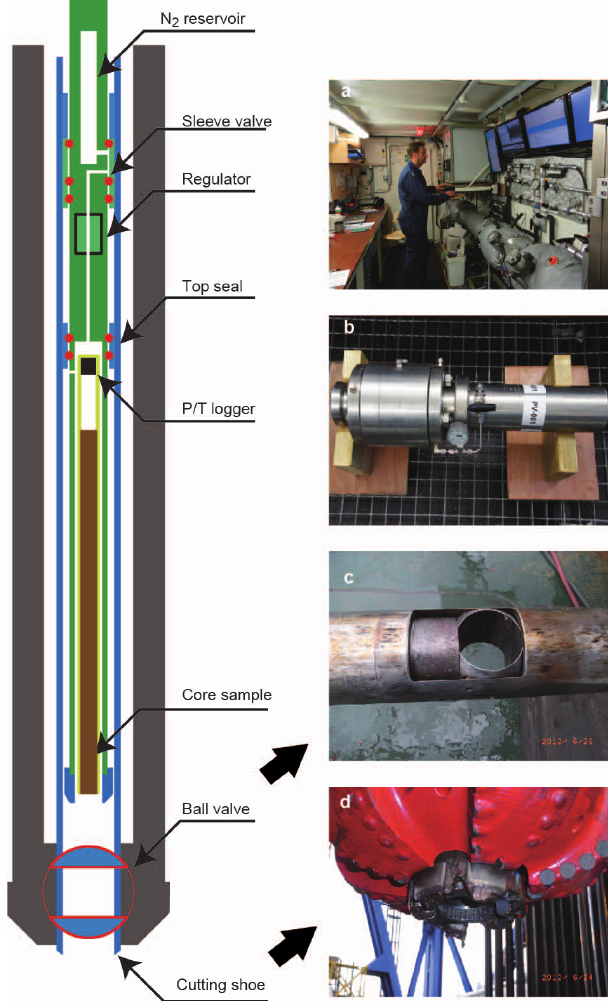
Figure 1. Schematic illustration of the hybrid pressure coring sys- tem showing the sealing mechanism by the top seal and the bottom ball valve. The autoclave is connected to the N 2 reservoir that sup- ports the pressure at a predefined value. Pictures from expedition 906 show (a) a Geotek operator and equipment in the PCATS lab- oratory, (b) the storage chamber for a short sample (15cm), (c) a closed ball valve in the hybrid PCS, and (d) the PDC drill bit with a short cutting